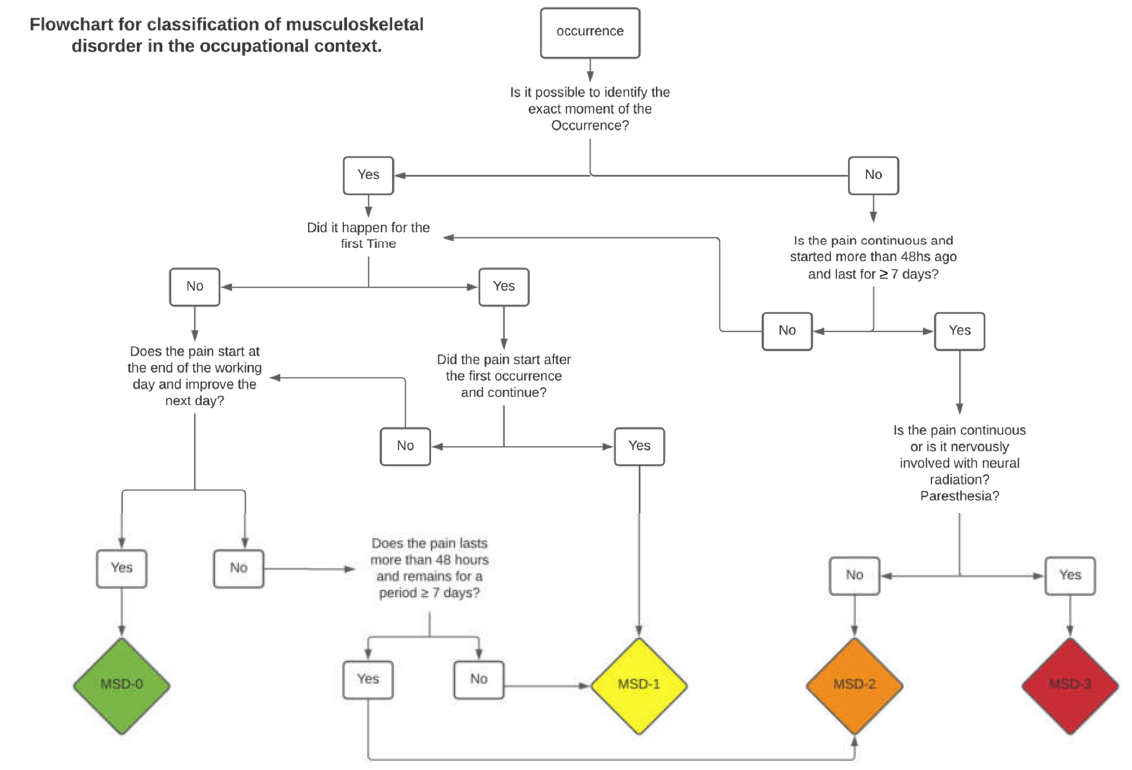
Figure 2. Flowchart for clinical decision in Occupational Context.